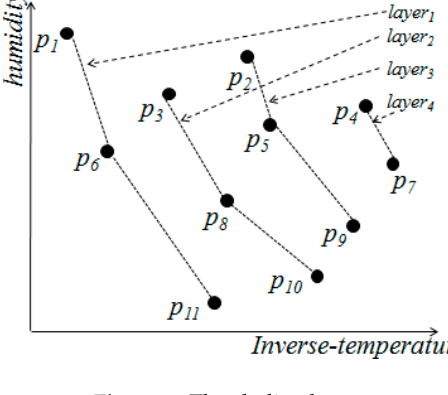
Figure 3. The skyline layers. Information 2018 , 9 , x